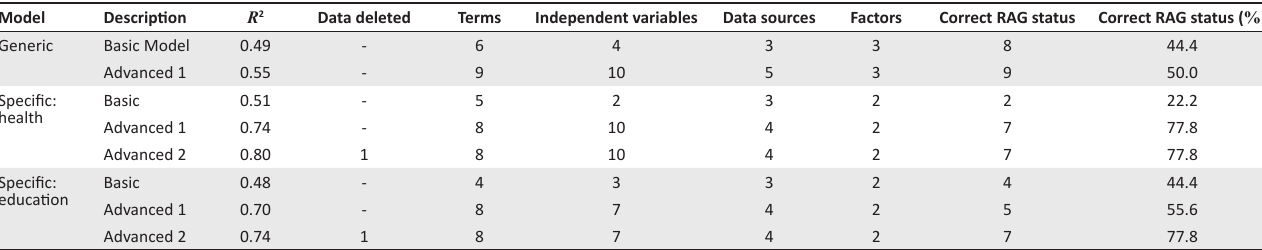
TABLE 7: Summary of the linear regression models. Model